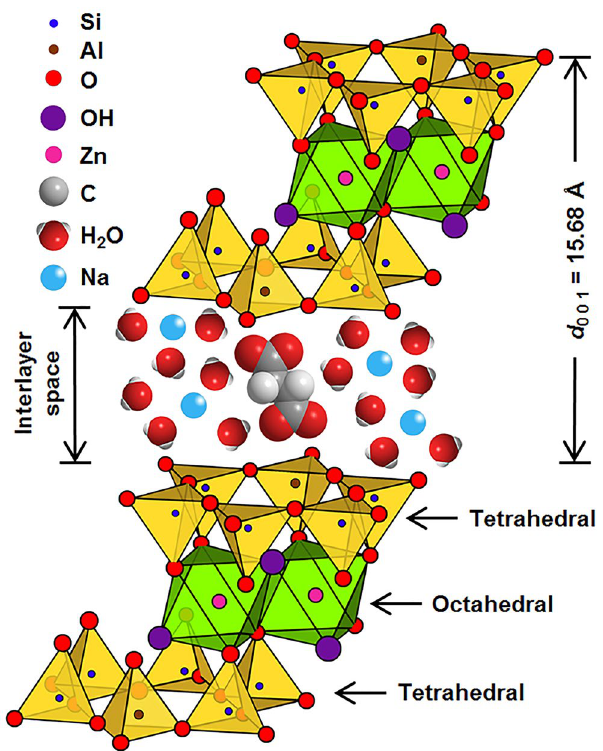
Figure 9. Model displaying the stacking order of layers in a 2:1 trioctahedral sauconite structure al synthesized during 20 h using 1.0 M succinate at pH 0 6.3 and 90 °C. The layer to layer distance d 0 0 1 = 15.68 Å is represented to be about 3-times larger than the length of succinate that appears longitudinally oriented perpendicular to tetrahedral aluminum